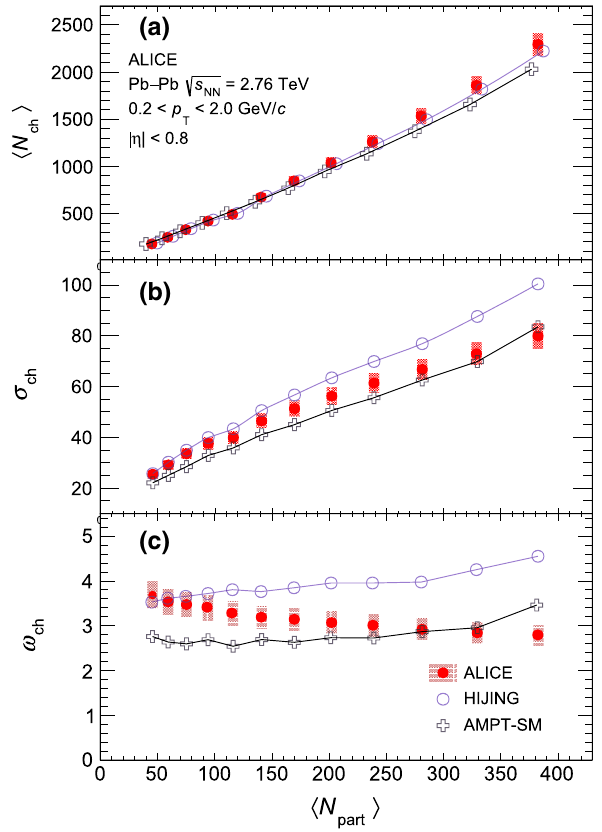
Fig. 1 Mean ( (cid:3) N ch (cid:4) ), standard deviation ( σ ch ), and scaled variance ( ω ch ) of charged-particle multiplicity distributions as a function of the number of participating nucleons for experimental data along with HIJING and AMPT (string melting) models for Pb–Pb collisions at √ s NN = 2.76 TeV, shown in panels a , b , and c , respectively. For panel a , (cid:3) N part (cid:4) for the two models are shifted for better visibility. The statisti- caluncertaintiesaresmallerthanthesizeofthemarkers.Thesystematic uncertainties are presented as filled boxes